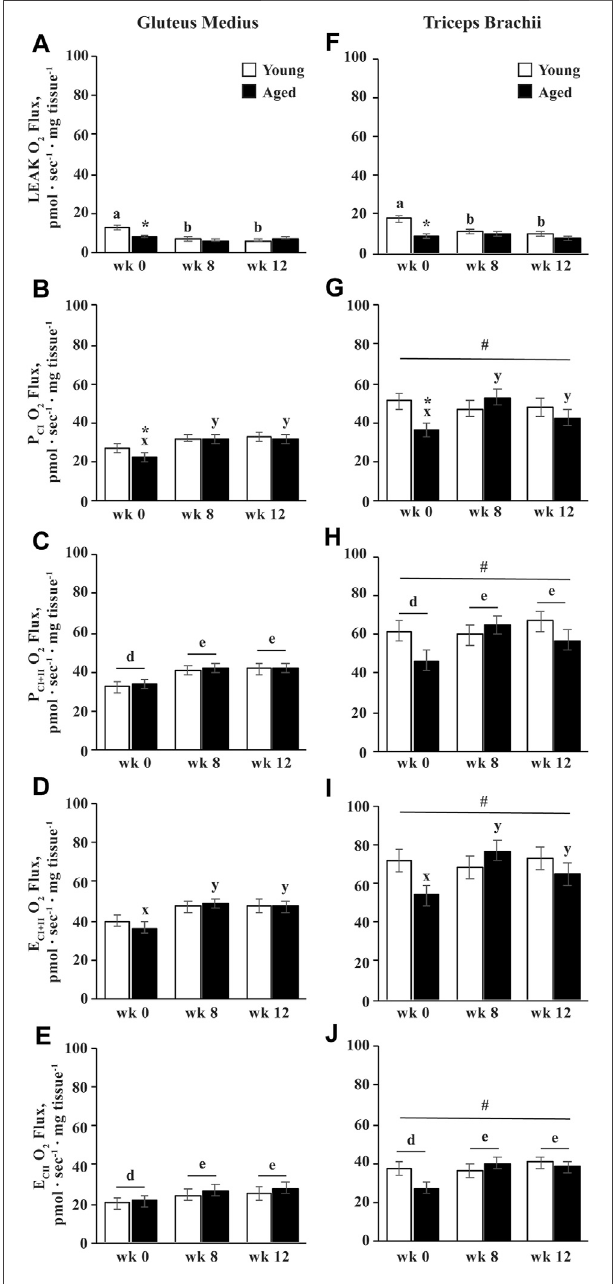
FIGURE 5 | Integrative (mass-speci fi c) mitochondrial respiration of permeabilized fi bers from the gluteus medius and triceps brachii analyzed via high-resolution respirometry. LEAK respiration (LEAK; A , F ), complex I-supported oxidative phosphorylation capacity (P CI ; B , G ), complex I and II-supported P (P CI+II ; C , H ), maximal noncoupled electron transfer system capacity (E CI+II ; D , I ), and complex II-supported E (E CII ; E , J ) were measured before (wk 0), and after 8 (wk 8) and 12 (wk 12) weeks of submaximal exercise training in aged (22 ± 4.5 yr; n (cid:1) 10) and young (9.7 ± 0.7 mo; n (cid:1) 8) horses. Overalleffectofage( p (cid:1) 0.0.002; p (cid:1) 0.2; p (cid:1) 0.2; p (cid:1) 0.3; p (cid:1) 0.6),training( p < 0.0001; p (cid:1) 0.01; p (cid:1) 0.003; p (cid:1) 0.004; p (cid:1) 0.0009),musclegroup( p < 0.0001; p < 0.0001; p < 0.0001; p < 0.0001; p < 0.0001),age × training( p < 0.0001; p (cid:1) 0.03; p (cid:1) 0.10; p (cid:1) 0.03; p (cid:1) 0.13), age × muscle group ( p (cid:1) 0.01; p (cid:1) 0.2; p (cid:1) 0.2; p (cid:1) 0.3; p (cid:1) 0.2), training × muscle group ( p (cid:1) 0.13; p (cid:1) 0.16; p (cid:1) 0.6; p (cid:1)